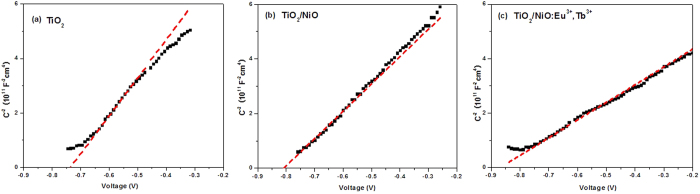
MS plots of (a) TiO2, (b) TiO2/NiO and (c) TiO2/NiO:Eu3+,Tb3+ in 0.5 M Na2SO4 electrolyte.